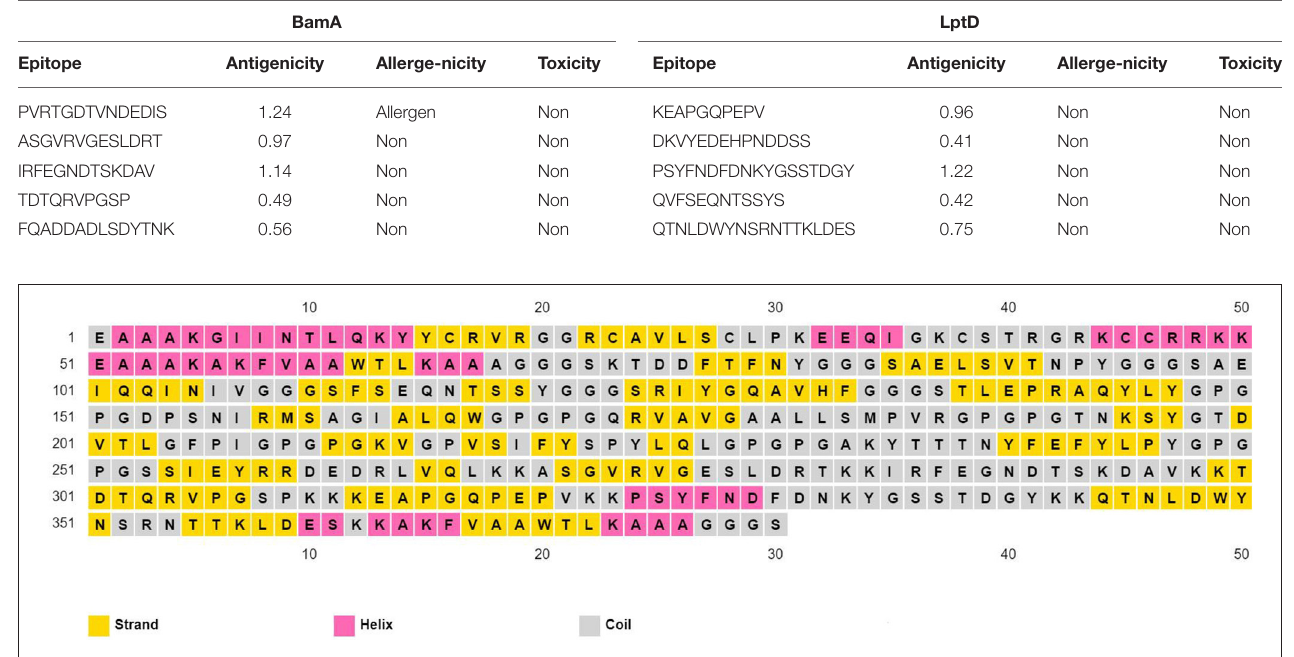
FIGURE 3 | Secondary structure prediction of designed multitope vaccine using PESIPRED server.